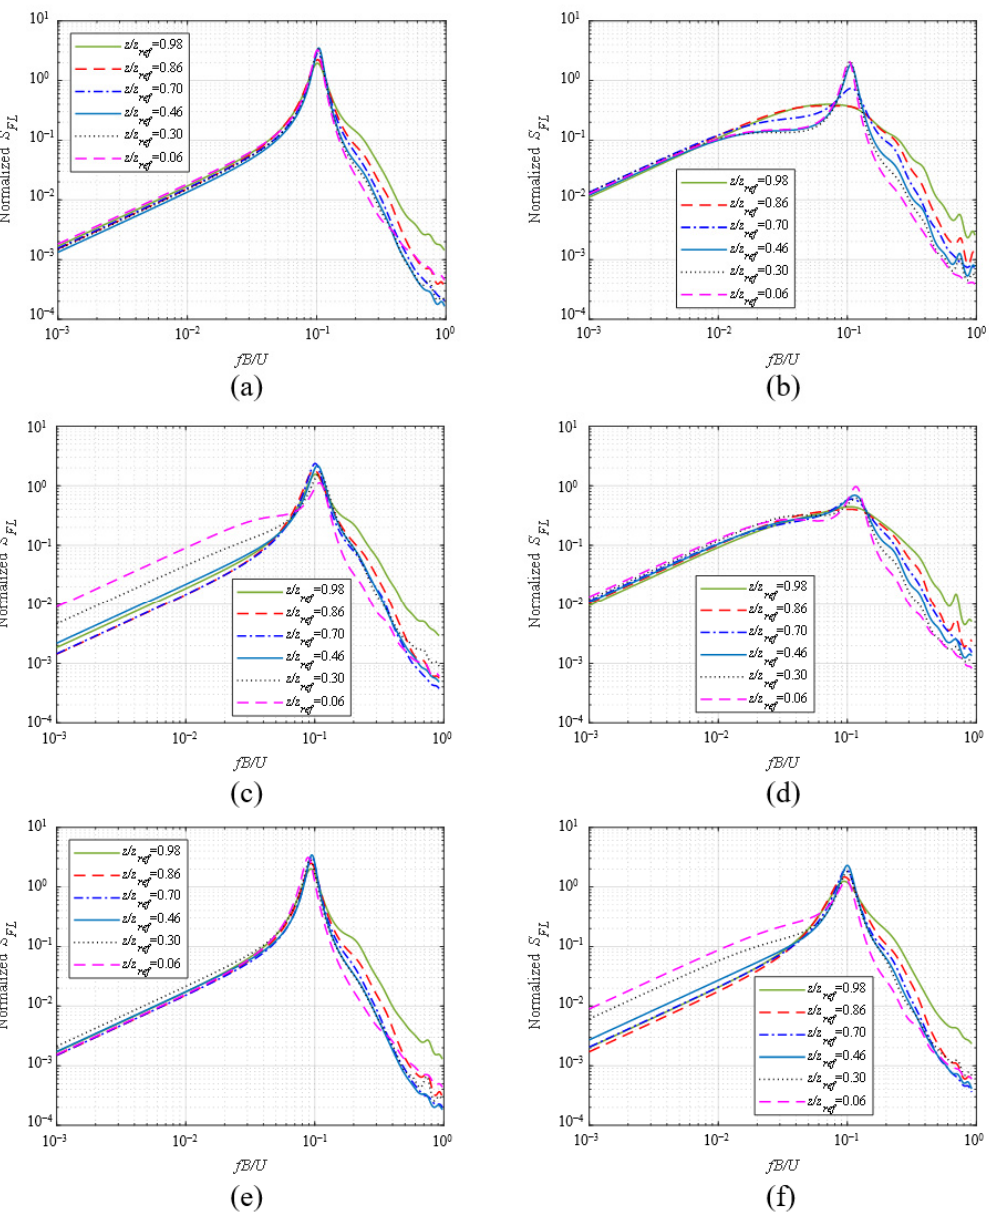
Figure 21. Power spectral densities of local across-wind load: ( a ) CWF1-0°; ( b ) CWF1-30°; ( c ) TWF30-0°; ( d ) TWF30-30°; ( e ) CWF2-0°; and ( f ) TWF20-0°.